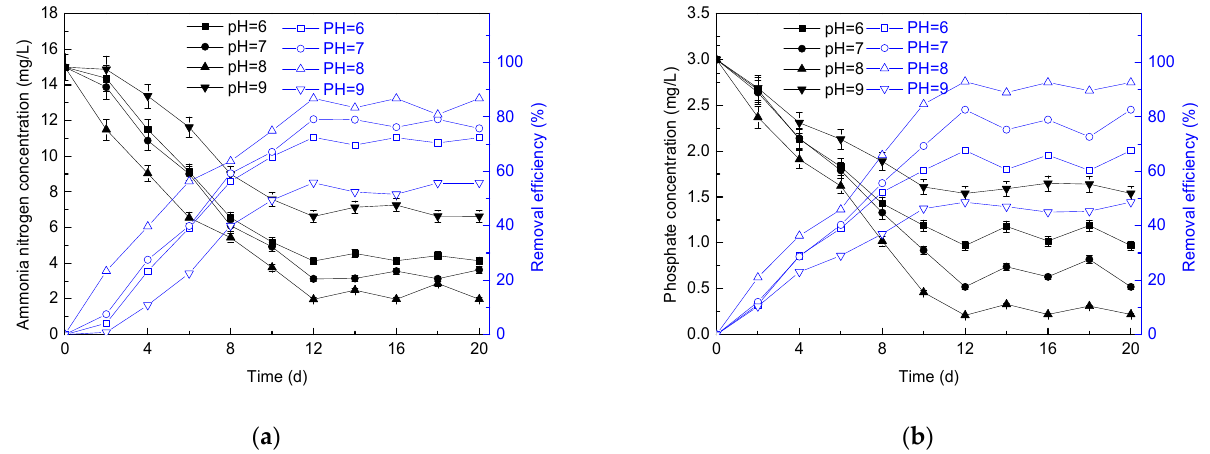
Figure 8. Changes in ammonia nitrogen ( a ) and phosphate ( b ) removal under different pH.